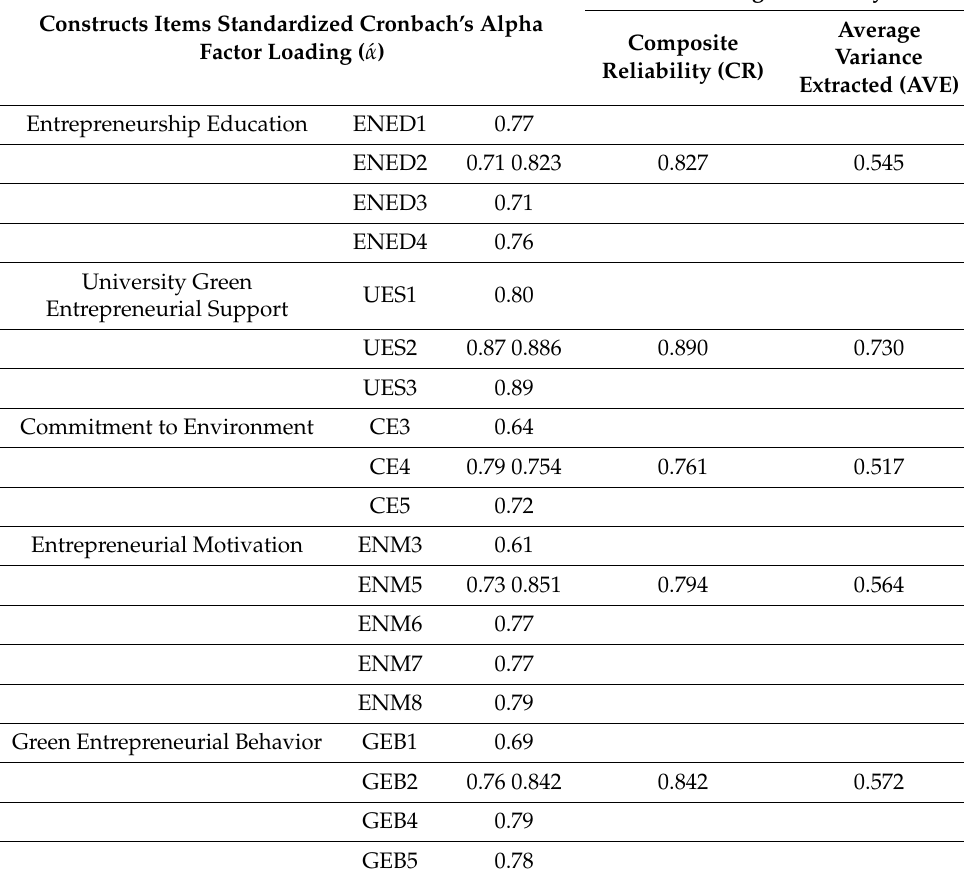
Table 1. Descriptive analysis and measurement model.